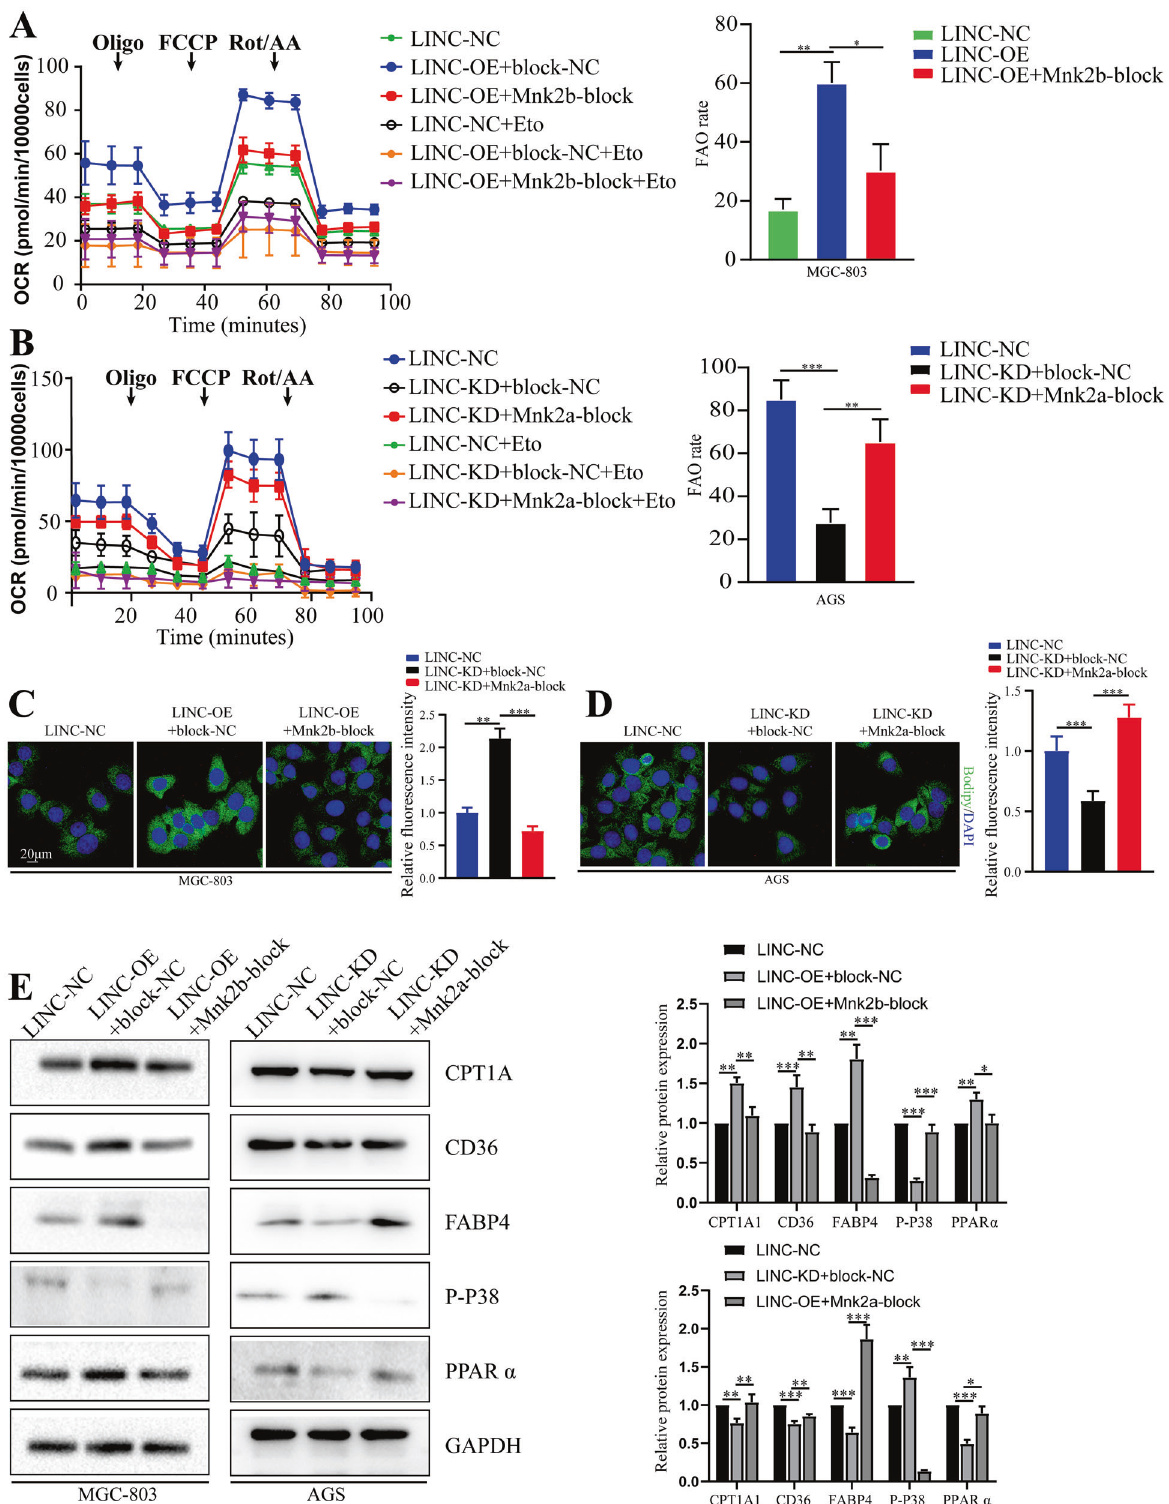
Fig. 6 Mnk2 AS is essential for LINC00924 regulating lipid metabolic reprogramming. A OCR analysis of MGC803-NC and LINC-OE cell lines treated with Mnk2b-block SSO or NC using palmitate as a metabolic substrate. B OCR analysis of AGS-NC and LINC-KD cell lines treated with Mnk2a-block SSO or NC using palmitate as a metabolic substrate. C Lipid droplet staining of AGS-NC and LINC-OE cells treated with Mnk2a- block SSO or NC. D Lipid droplet staining if MGC803-NC and LINC-KD cells treated with Mnk2a-block SSO or NC. E WB analysis of CPT1A, CD36, FABP4, p-P38, and PPAR α in MGC803-NC and LINC-OE cells treated with Mnk2b-block SSO or NC and AGS-NC and LINC00924-KD cells treated with Mnk2a-block SSO or NC.